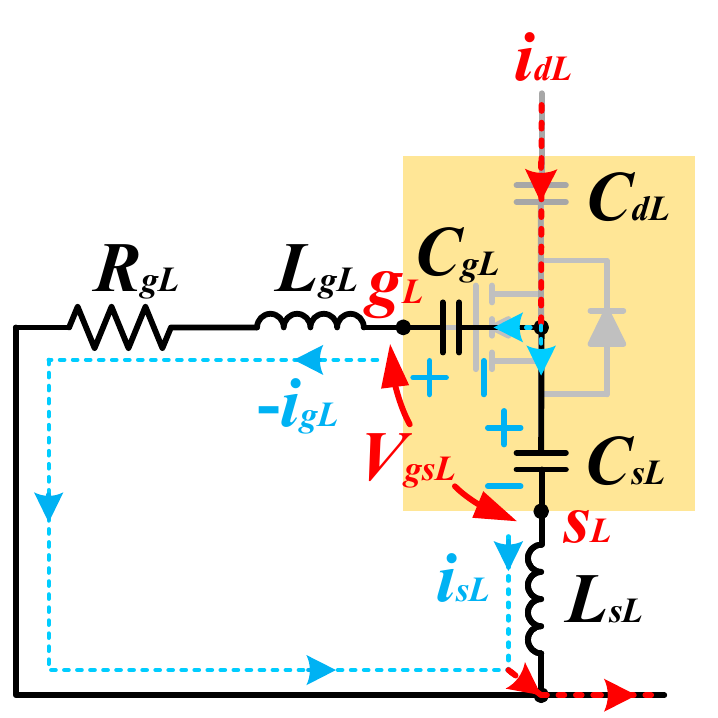
Figure 16. Equivalent circuit for the driver loop of Q L.